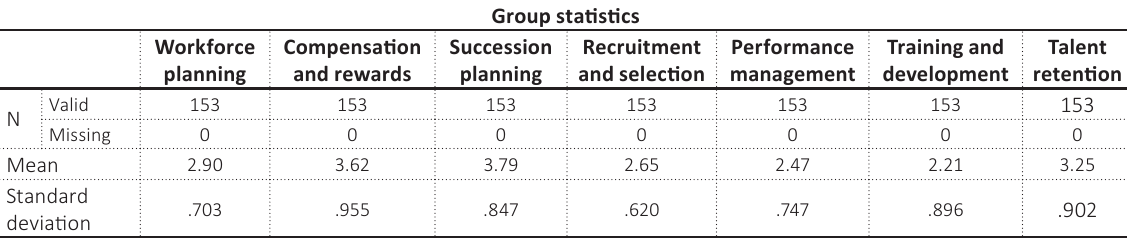
Table 2. Standard deviations and means for WP, CR, SP, RS, PM, TD, and